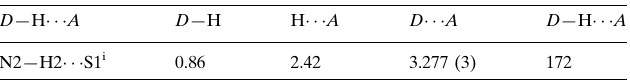
Hydrogen-bond geometry (A˚ , (cid:1)